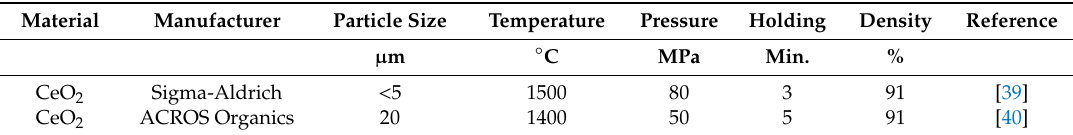
Table 2. Literature survey of FAST / SPS of undoped ceria. In these works, the authors report crack formation or disintegration of